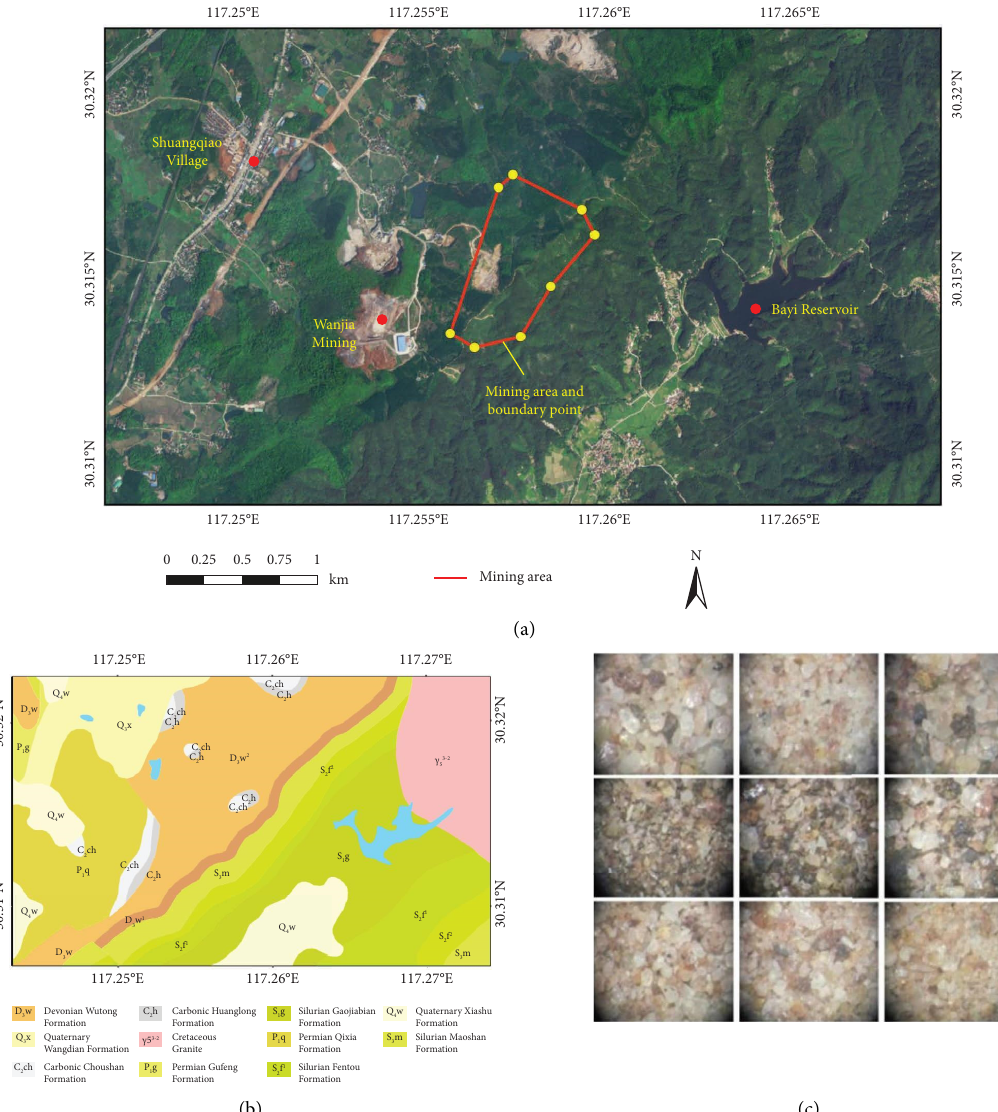
Figure 1: (a) Location of the mining area in Juanqiao city, Guichi district, Chizhou city, Anhui province, China; (b) geological map of the mining area; (c) part of the images of the quartz ore samples under the